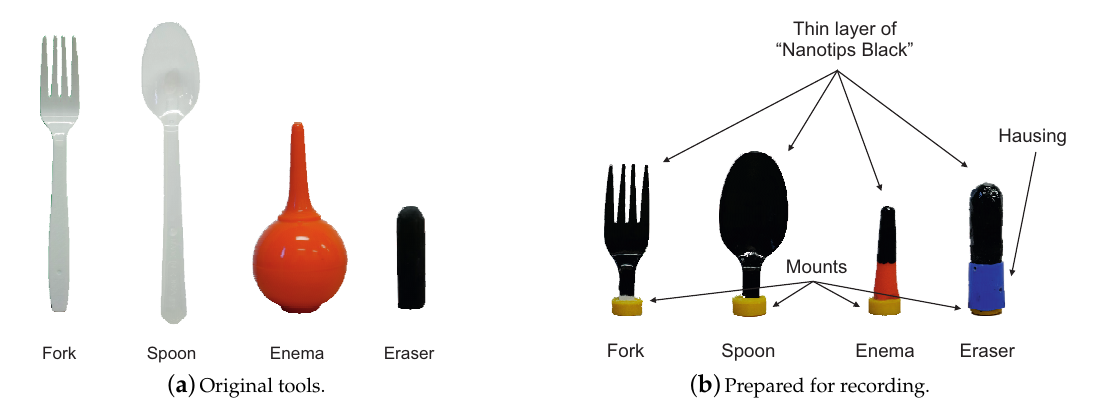
Figure 5. A set of real tools for evaluation: ( a ) illustration of original tools; and ( b ) modified versions of tools prepared for numerical and psychophysical